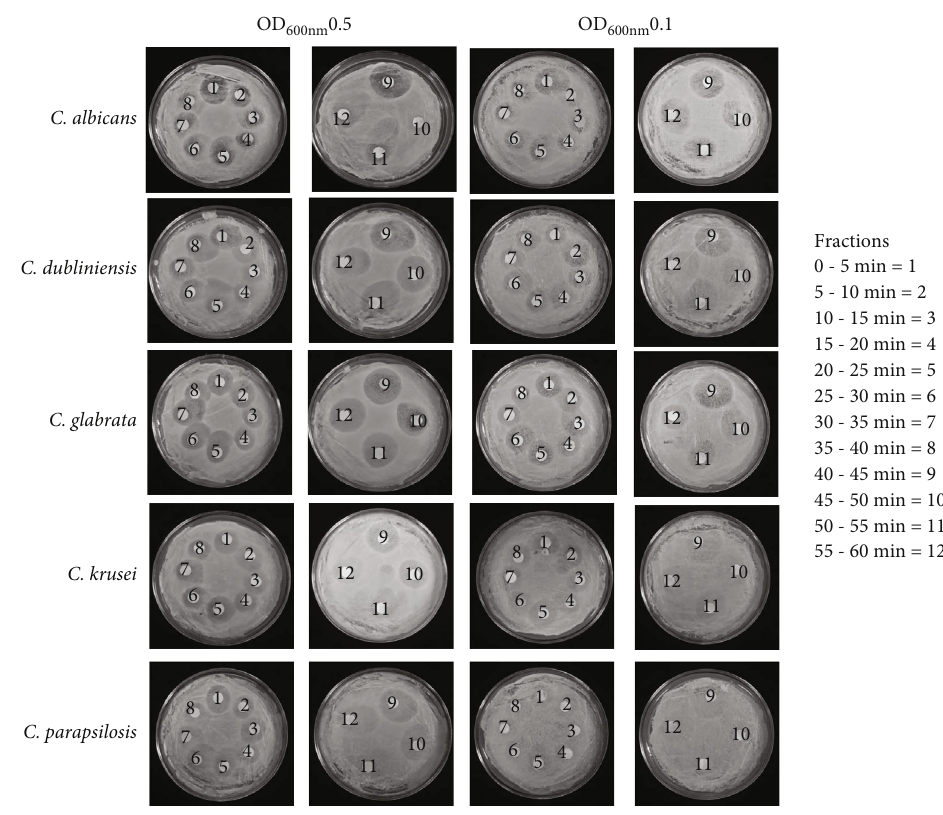
Figure 5: Susceptibility assays of the 12 pure fractions obtained from